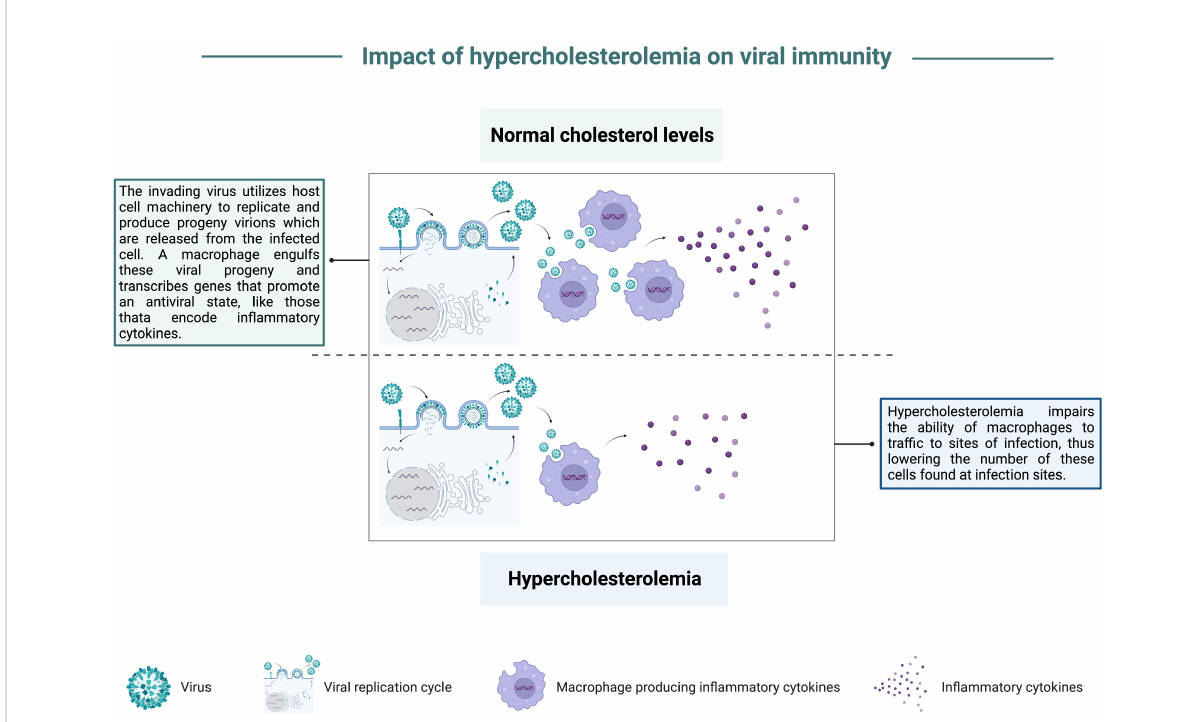
FIGURE 3 Impact of hypercholesterolemia on viral immunity. In a state of normal cholesterol levels, an invading virus hijacks host cell machinery to replicate and produce progeny virions that are released from the infected cell. A macrophage recruited to the infection site can engulf viral progeny and contribute to the anti-viral state by transcribing genes that stimulate the innate immune response, like pro-in fl ammatory cytokine- encoding genes. In a state of hypercholesterolemia, there is a defect in macrophage recruitment to infection sites. Consequently, there are fewer macrophages found at infection sites, blunting this arm of the immune